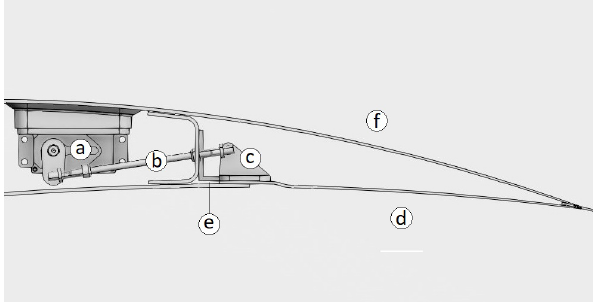
Figure 7. Cross-sectional view of the module showing the internal setup and morphing mechanism. This includes (a) the servo, (b) the servo arm, and (c) the pickup that, in turn, is connected to (d) the sliding lower surface. This lower surface moves in and out of (e) the slot. The fibers are bonded on the internal surface of (f) the upper surface of the module that seamlessly connects to the wingbox.